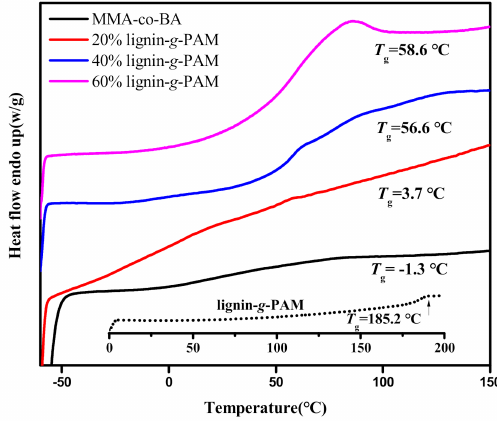
Figure 6. Differential scanning calorimetry (DSC) curves of lignin-g-PAM, pure MMA- co -BA, and lignin-grafted hybrid acrylic